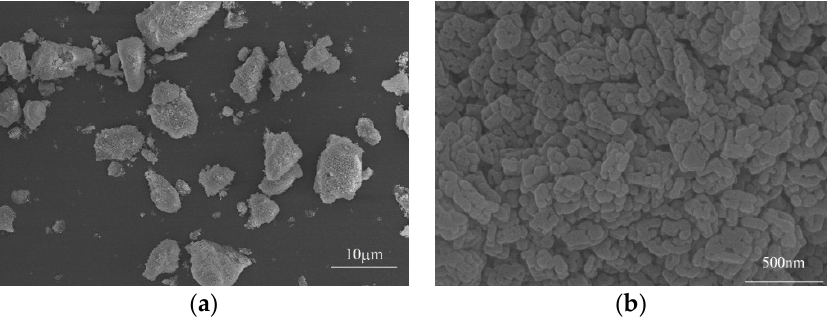
Figure 1. SEM micrographs of the high-activity magnesia powder ( a ) magnesia particles. and ( b ) surface of magnesia particle.